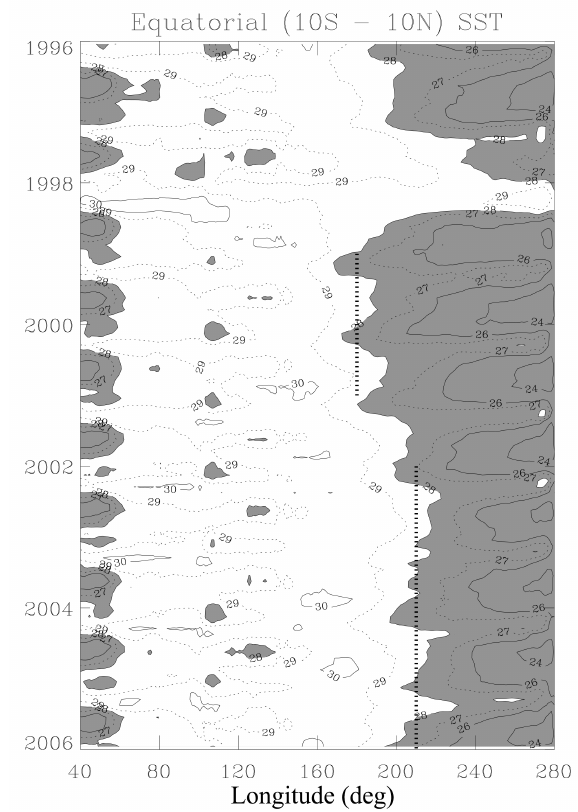
Figure 10. Longitude–time section of sea surface temperature (SST) averaged over the oceanic region of the latitude band be- tween 10 ◦ N and S of the Equator during the period from January 1996 to December 2005. The region with the SST colder than 28 ◦ C is shaded. The dashed line spans from January 1999 to Decem- ber 2000 along 180 ◦ E and from January 2002 to December 2005 along 210 ◦ E. Data are from NOAA OI SST